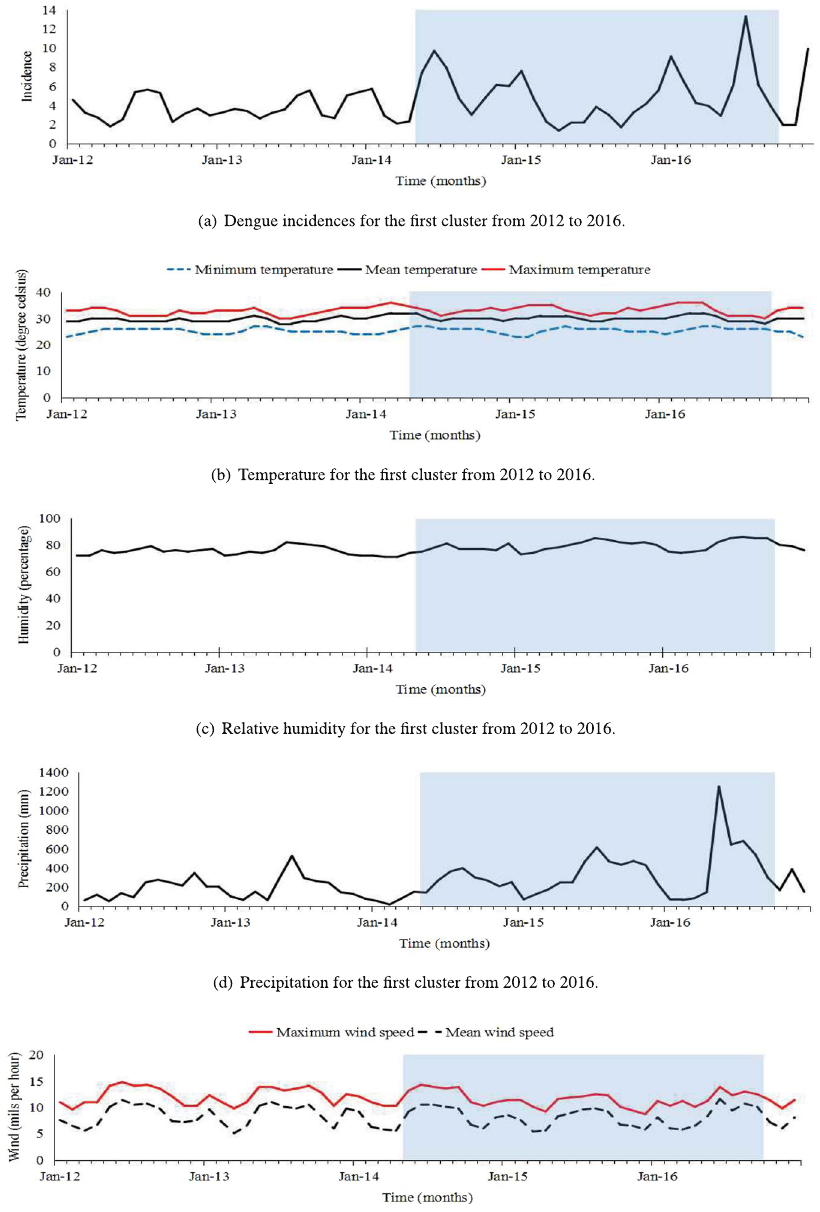
Figure 2. Dengue incidences and monthly climatic factors between 2012 and 2016 for the first cluster. The clustering period is highlighted in blue from May 2014 to September